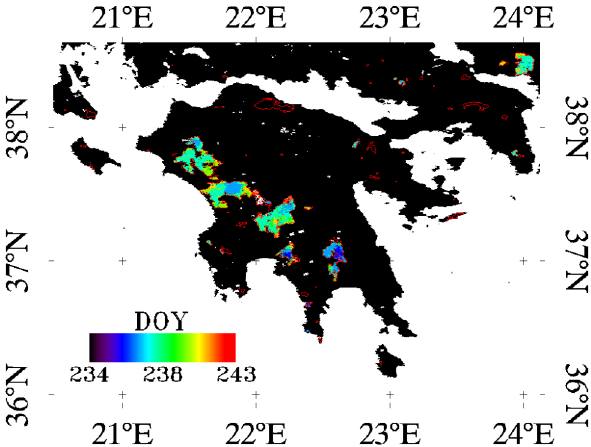
Figure 8. The Peloponnese wildfires as viewed by the MODIS 500m burned area of Roy et al. (2005) collected in August and September 2007 and coloured by day of the year they were de- tected (DOY). The fires occurred in areas of forest, shrublands and olive groves and affected 1847km 2 according to these data. Also shown as a red outline are the 2007 burned area perimeters extracted from the European Forest Fire Information System (EFFIS; Euro- pean Commission, 2010) that encompass 1628km 2